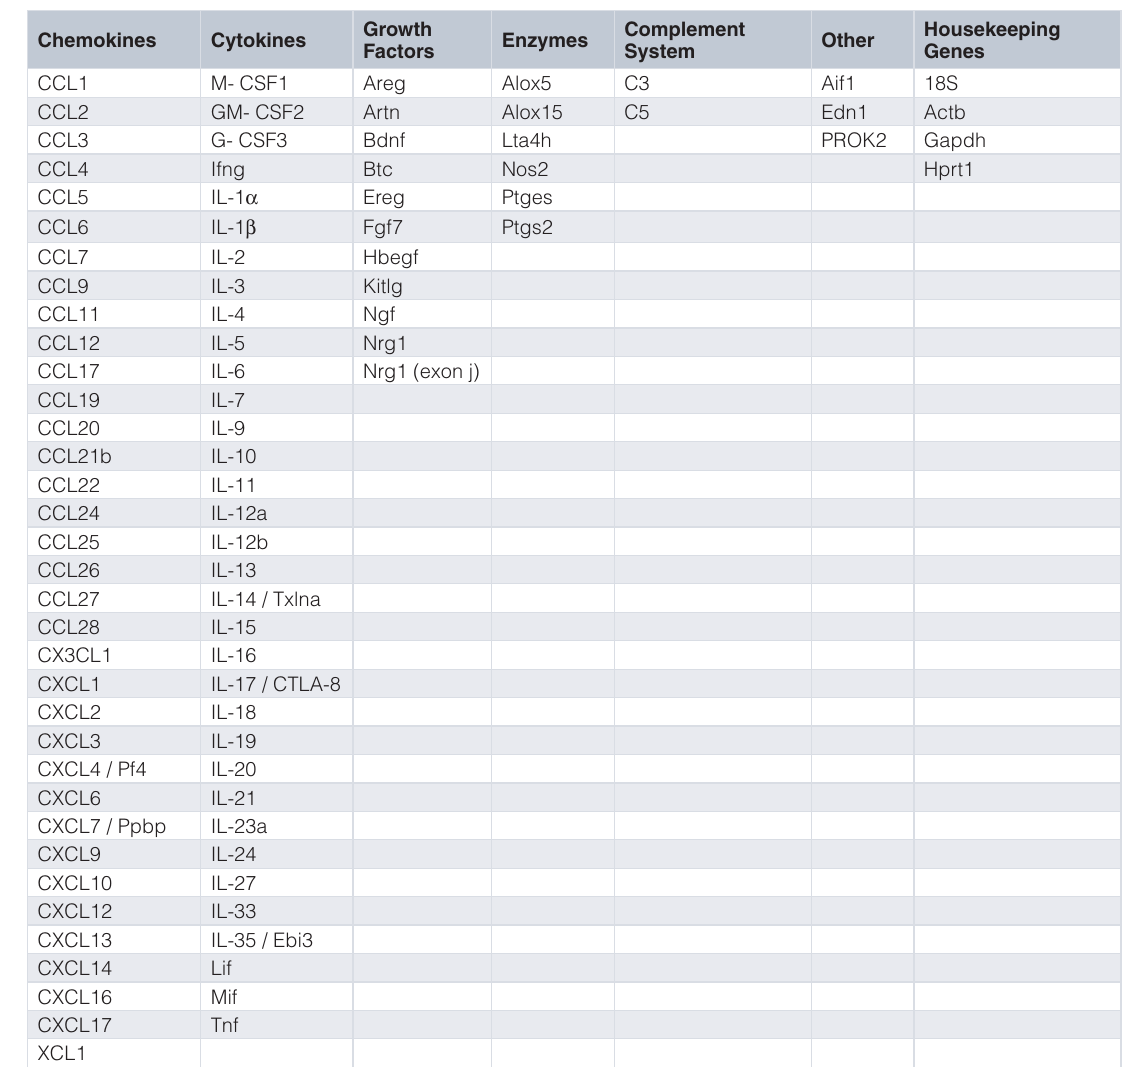
Table S1. Cytokine qRT-PCR Array Card Targets. Chemokines Cytokines